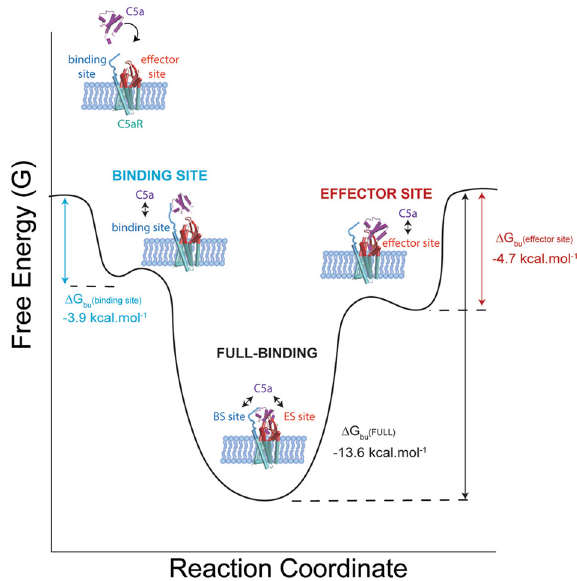
Fig. 6 Illustration of the free-energy binding landscape of C5a binding to C5aR. Δ G bu gives the free-energy difference between the ligand-bound and unbound states and is indicated for each binding site (binding site, effector site, and binding site + effector site) by vertical arrows. A positive allosteric interaction is measured when both binding sites (binding site and effector site) are occupied, as revealed by a signi fi cantly higher Δ G bu for the full binding of the